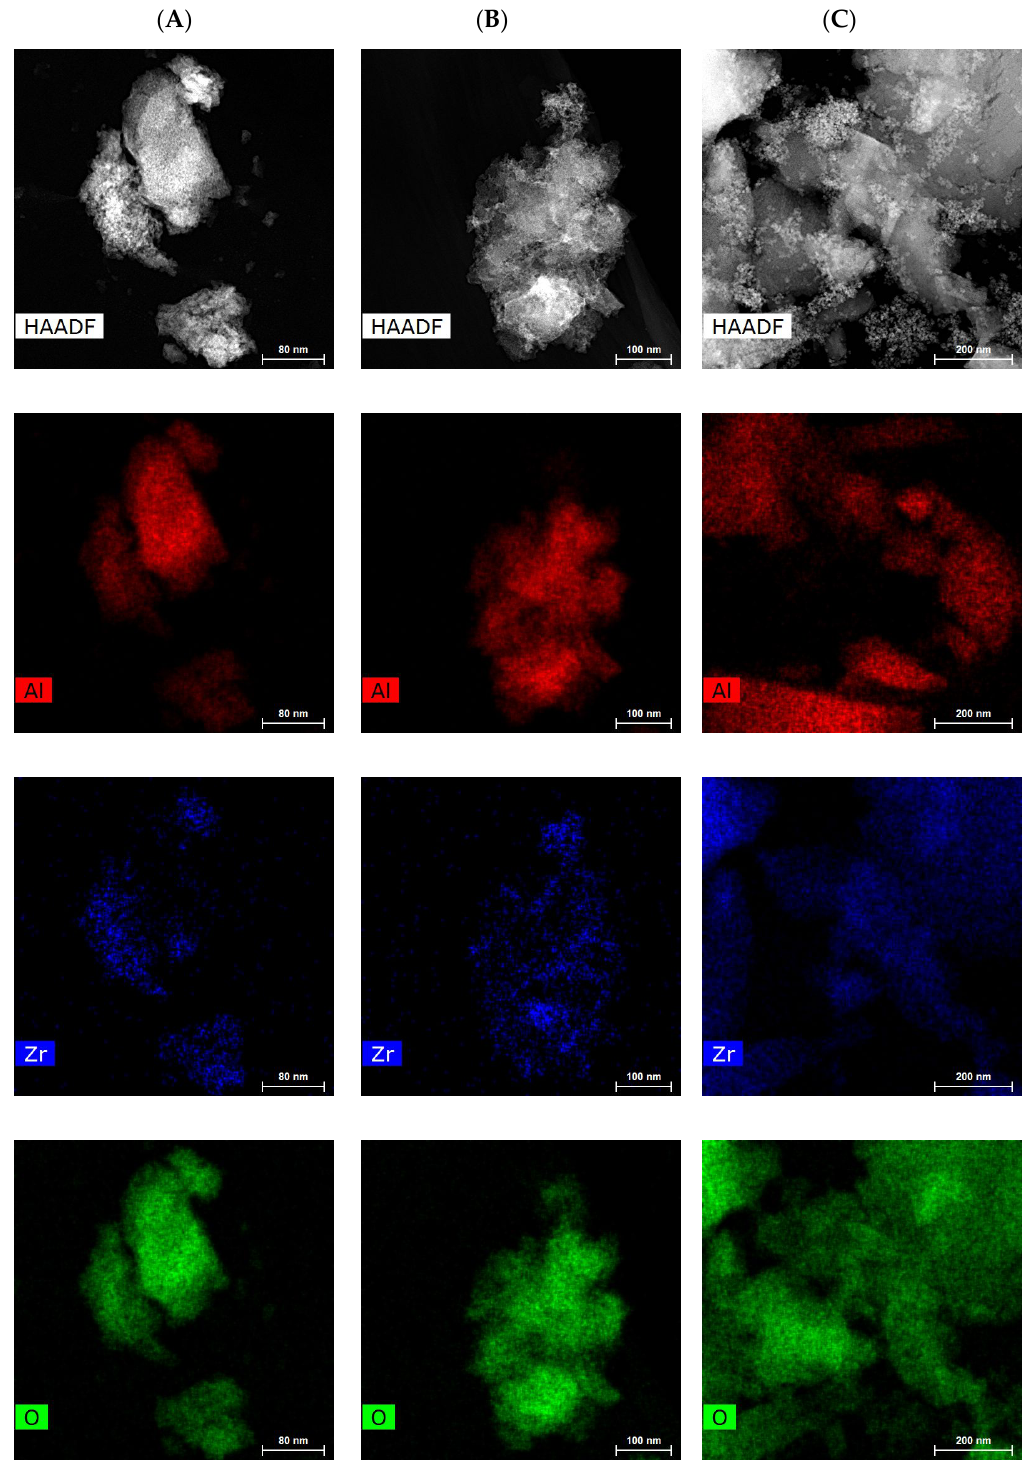
Figure 3. STEM-HAADF (High-angle annular dark-field) images of mixed AlZr oxides. ( A ) Al 7 Zr 3 ( B ) Al 5 Zr 5 , and ( C ) Al 3 Zr 7 .